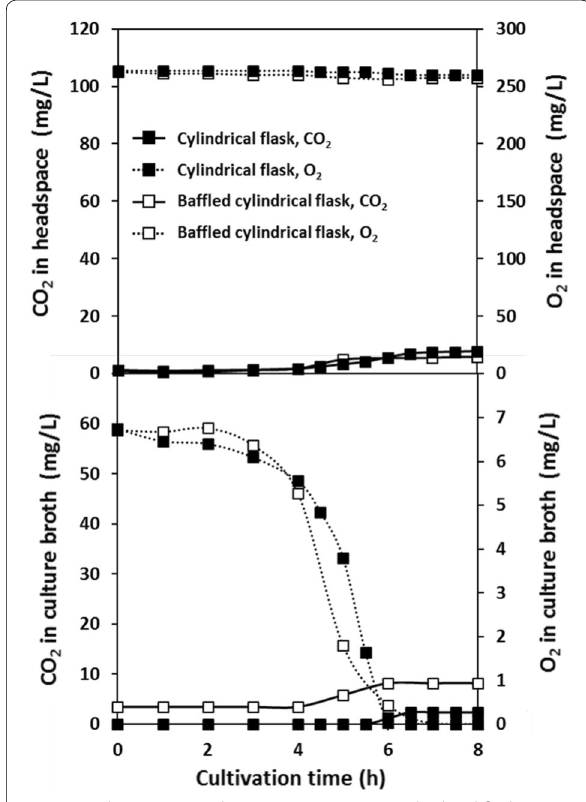
Fig. 4 Real-time CO 2 and O 2 concentrations in cylindrical flasks during shaking culture of E. coli K12 IFO3301. Shake-flask culture conditions were 100 and 50 mL of LB medium at 30 °C, 200 rpm with 70 mm shaking diameter, and 500-mL cylindrical flask without baffle and 500-mL baffled cylindrical flask, both equipped with breathable culture stoppers and CDMSS